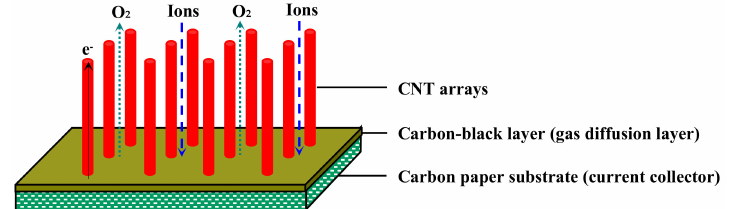
Figure 1. The schematic diagram of carbon nanotube (CNT) array / carbon-black layer / carbon paper substrate [25].